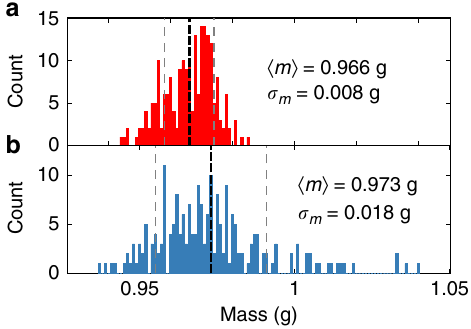
Fig. 8 Distribution of particle masses. a Clockwise and b counter-clockwise spinning rotors mass distributions. The dashed lines indicate mean 〈 m 〉 and standard deviation σ m . The width of the distribution is larger for counter- clockwise spinning rotors due to the additional manufacturing step of coloring its top Langevin dynamics simulations . Rotors are modeled by a large central disk (diameter 15mm) and four satellite disks (diameter 3.4mm). The diameter of the satellite disks is chosen such that the area covered by a particle equals that of the experiment. As typical for granular matter, we assume a viscoelastic normal contact _ ξ ∂ F force of the form F vis ¼ F el ð ξ Þ þ t vis el ∂ ξ , where ξ is the compression or indentation depth of neighboring particles (which is only microscopic in our system) and t vis is the viscous relaxation time describing the dissipative part of the force. Tangential forces between colliding discs are neglected. The elastic contact force of contacting cylinders is given by